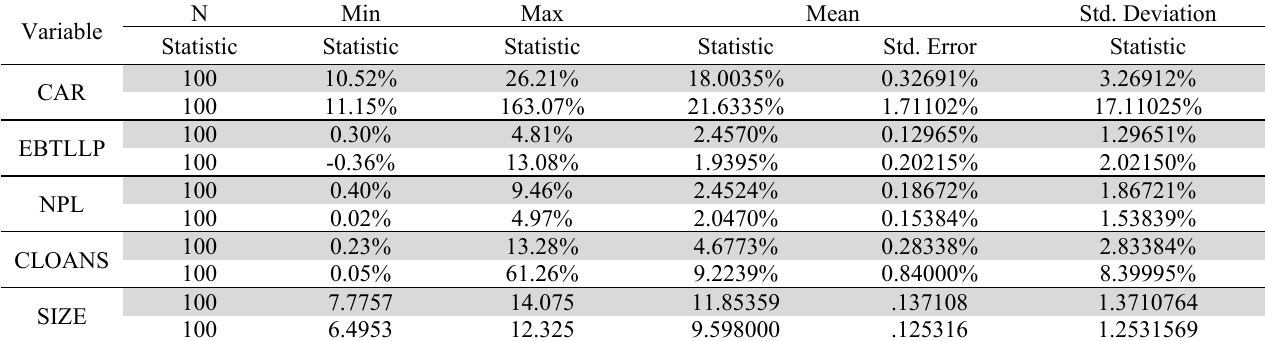
One-Sample Kolmogorov-Smirnov Test Normal Parameters